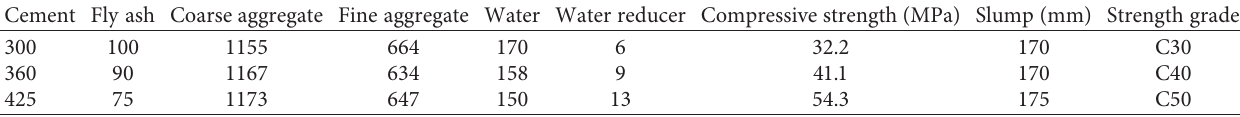
Table 2: Concrete mix ratio and physical properties (Kg/m 3 ).